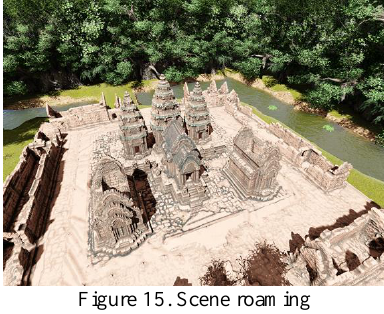
Figure 15. Scene